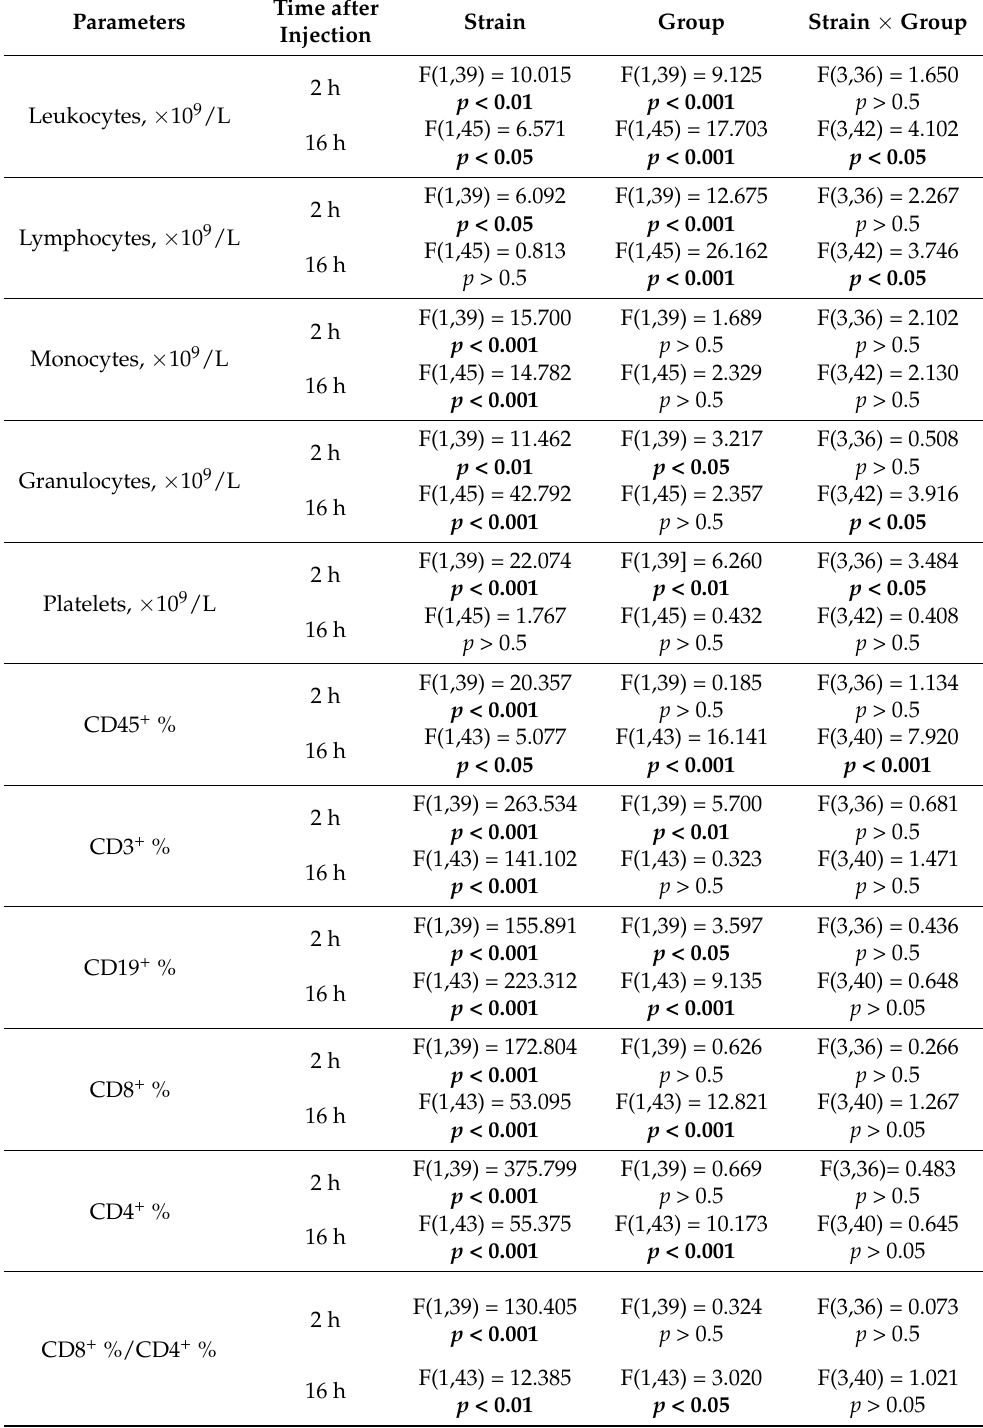
Table 1. Results of statistical analysis of the complete blood count and data on different types of